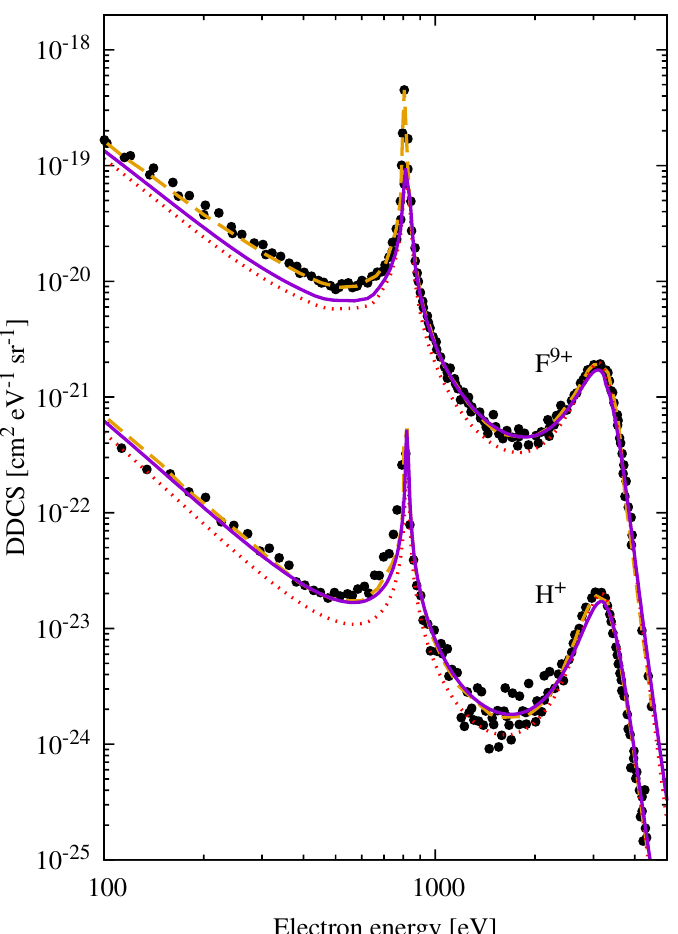
Figure 2. Double differential cross-section for the single ionization of He atoms by 1.5 MeV/u F 9 + and H + impact as a function of the electron energy for a 0 ◦ fixed emission angle. Theory: dotted-line, post CDW; full-line, complete hybrid post CDW; dashed-line, CDW theory from [10]; experiments, circles